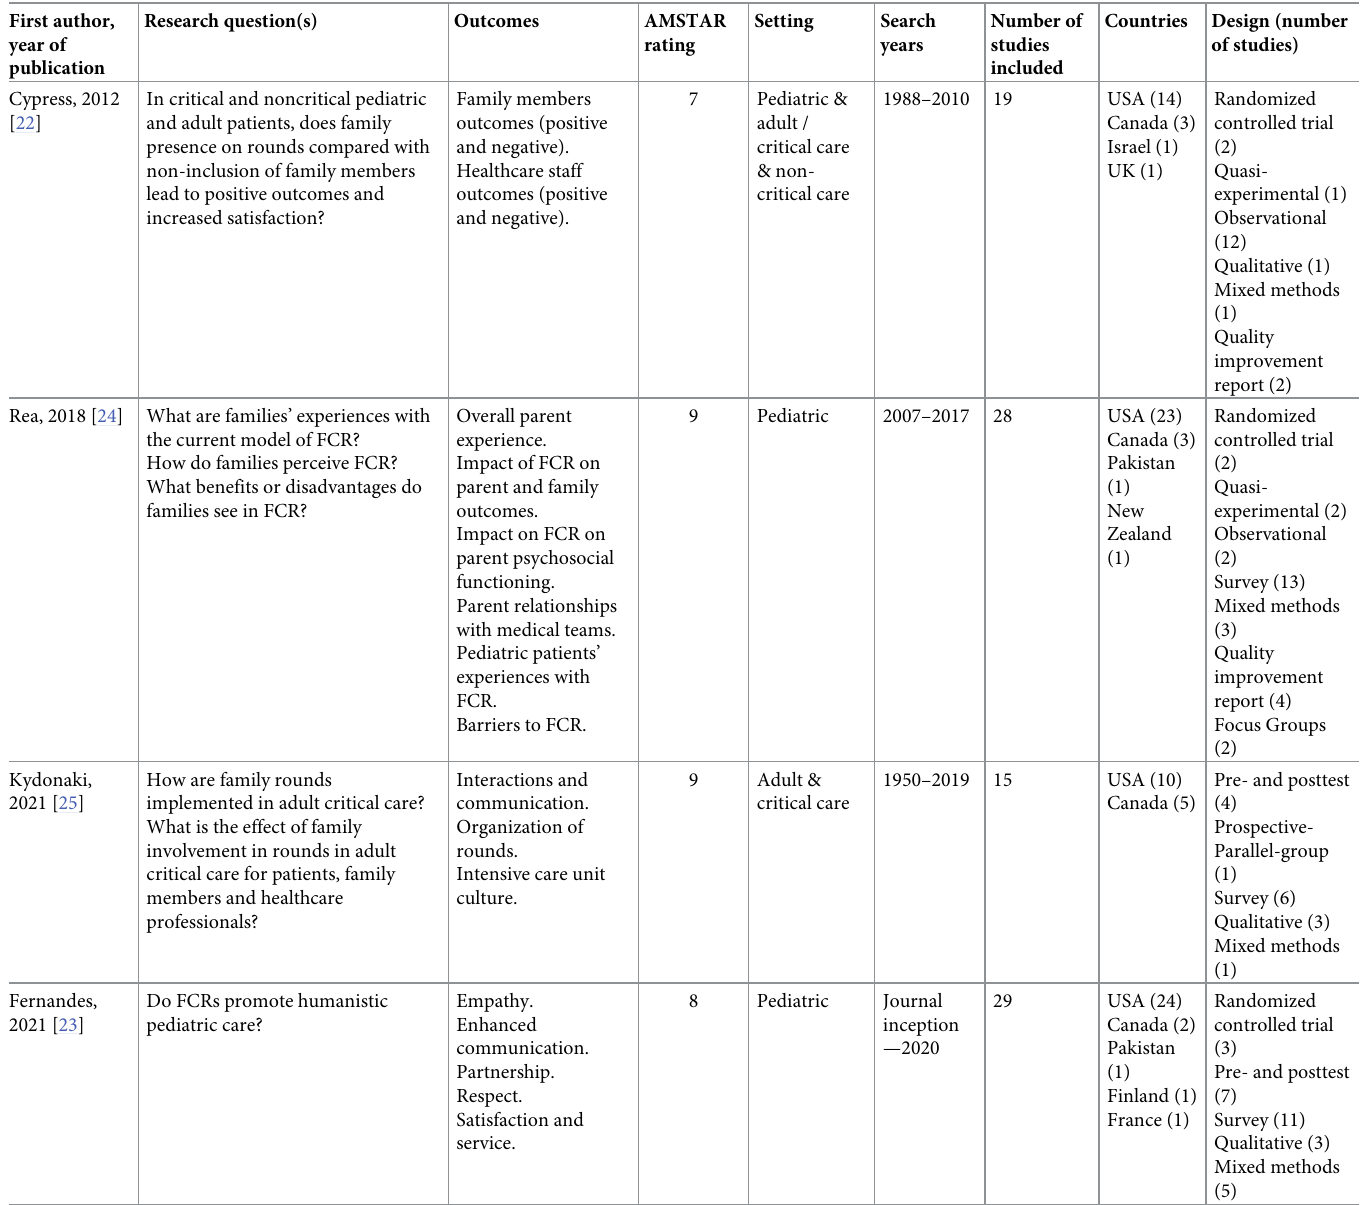
Table 3. Characteristics of the included